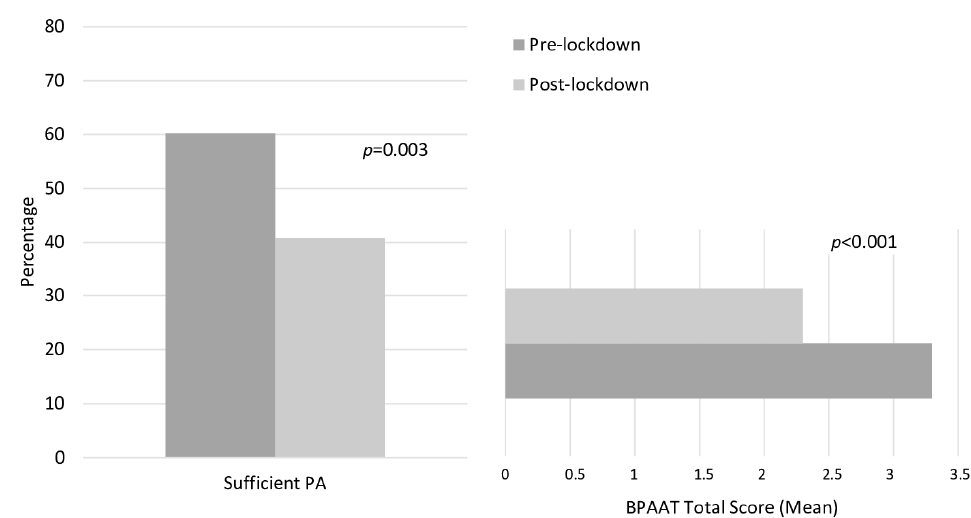
Figure 1. Effect of the strict lockdown due to COVID-19 pandemic on physical activity. The McNemar’s test for repeated samples was used for categorical variables. Paired sample t -test for repeated samples was used for continuous variables. Brief Physical Activity Assessment score ranged from 0–8 ( ≥ 4 points: sufficient active, 0–3: insufficient active).